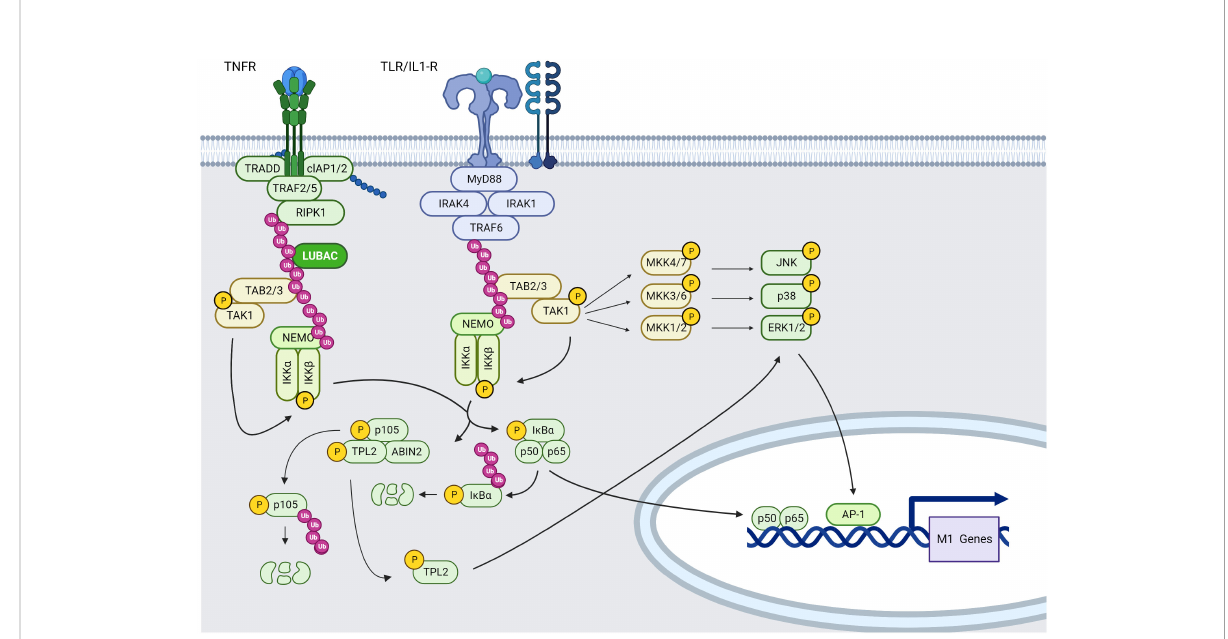
FIGURE 2 TNFR and TLR/IL-1R, NF- k B and MAPK signaling pathways in macrophages (created using BioRender ®